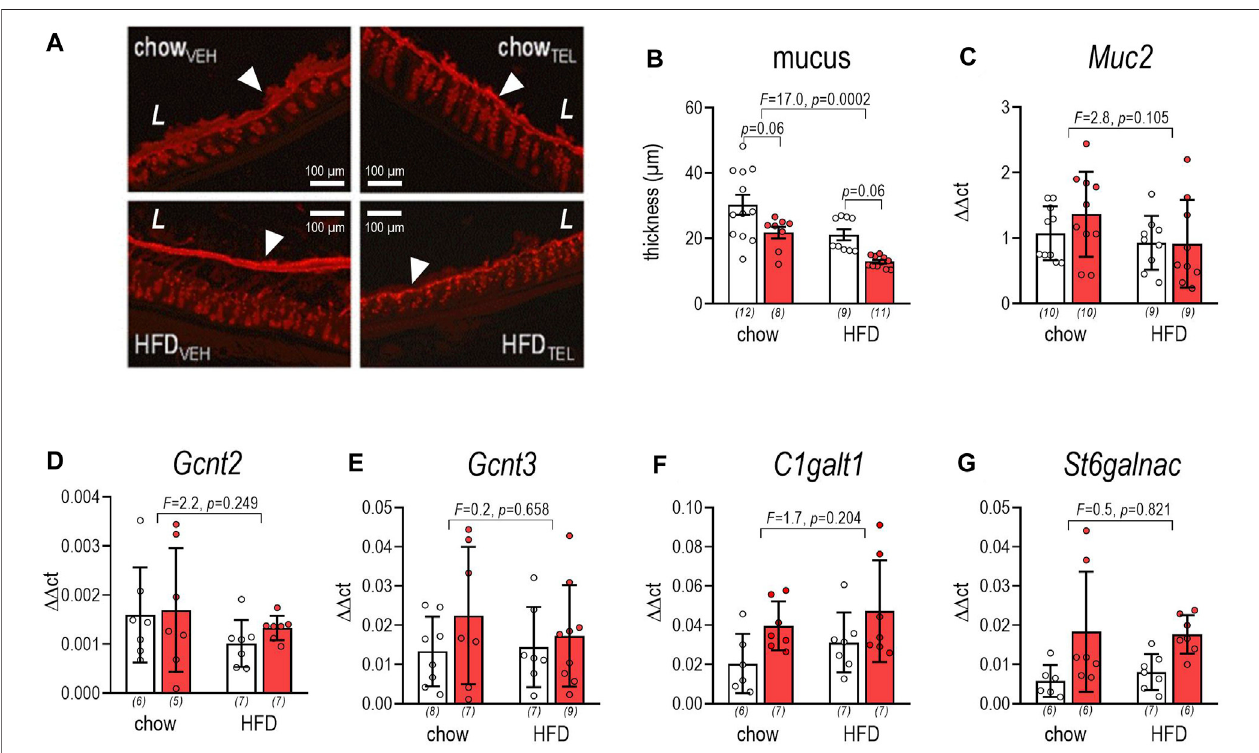
FIGURE3| EffectofTEL( C ,8 mg/kg/dayredbars)orvehicletreatment openbars(O)onmucusthicknessoflargeintestineofmicethatwerefedeitherwithchow or high fat diet (HFD). (A) staining against mucin-2 (arrows indicate mucus, L indicates the intestine lumen); (B) thickness of mucus; thickness was quanti fi ed using ZEN 2.3 imaging software by 40-fold multiple measurement per animal in different sections (for further details see also Supplementary Figure S4 ); two-way ANOVA; TEL: F = 20.1, p < 0.0001); (C) α mucin-2 expression (two-way ANOVA; TEL: F = 0.6, p = 0.441); (D) Gcnt2 expression (two-way ANOVA; TEL: F = 0.4, p = 0.517); (E) Gcnt3 expression (two-way ANOVA; TEL: F = 1.7, p = 0.202); (F) c1galt1 expression (two-way ANOVA; TEL: F = 6.4, p = 0.018); (G) St6galnac expression (two-way ANOVA; TEL: F = 10.8, p = 0.003). Means ± SD; the individual group size is indicated below the bars in brackets.